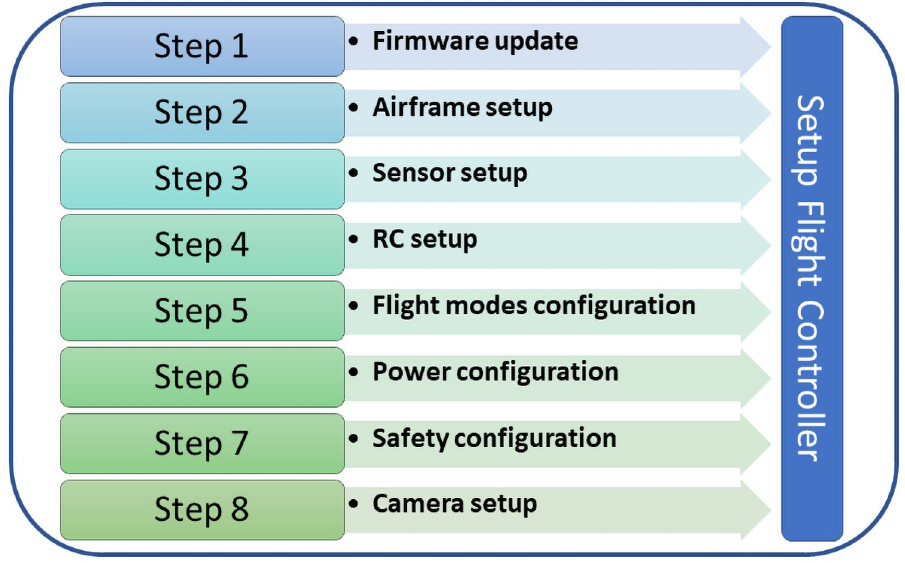
Fig 3. Steps for setup flight